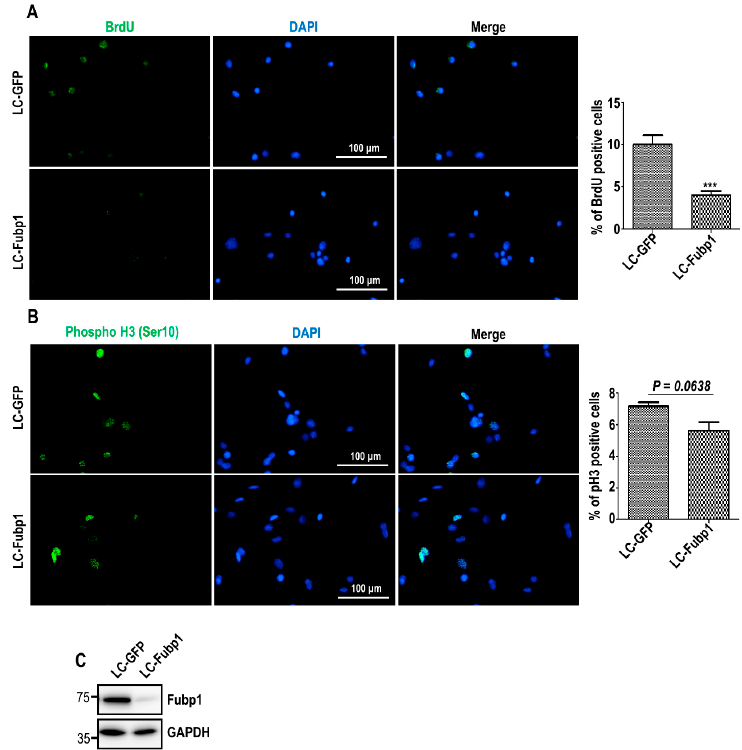
Figure 2. Disruption of cell cycle progression under Fubp1 deficiency. ( A ) BrdU staining was performed in LC-GFP and LC-Fubp1 cells. Green signals indicated BrdU-positive cells. Nuclear DAPI (4’,6-diamidino-2-phenylindole) staining is shown in blue. The quantification of the proportion of BrdU-positive control and Fubp1-deficient cells is shown in the right panel. *** p < 0.001 . ( B ) Immunofluorescence analysis of phospho-Histone3 (pH3) at Ser 10 (shown in green). Nuclear DAPI staining is shown in blue. The quantification of the proportion of pH3-positive control and Fubp1-deficient cells is shown in the right panel. ( C ) Confirmation of Fubp1 deficiency by immunoblotting. GAPDH was used as a loading control. Over 800 cells were counted from 10 random fields of view per group for statistical analysis. Data were replicated in two independent experiments with similar results.